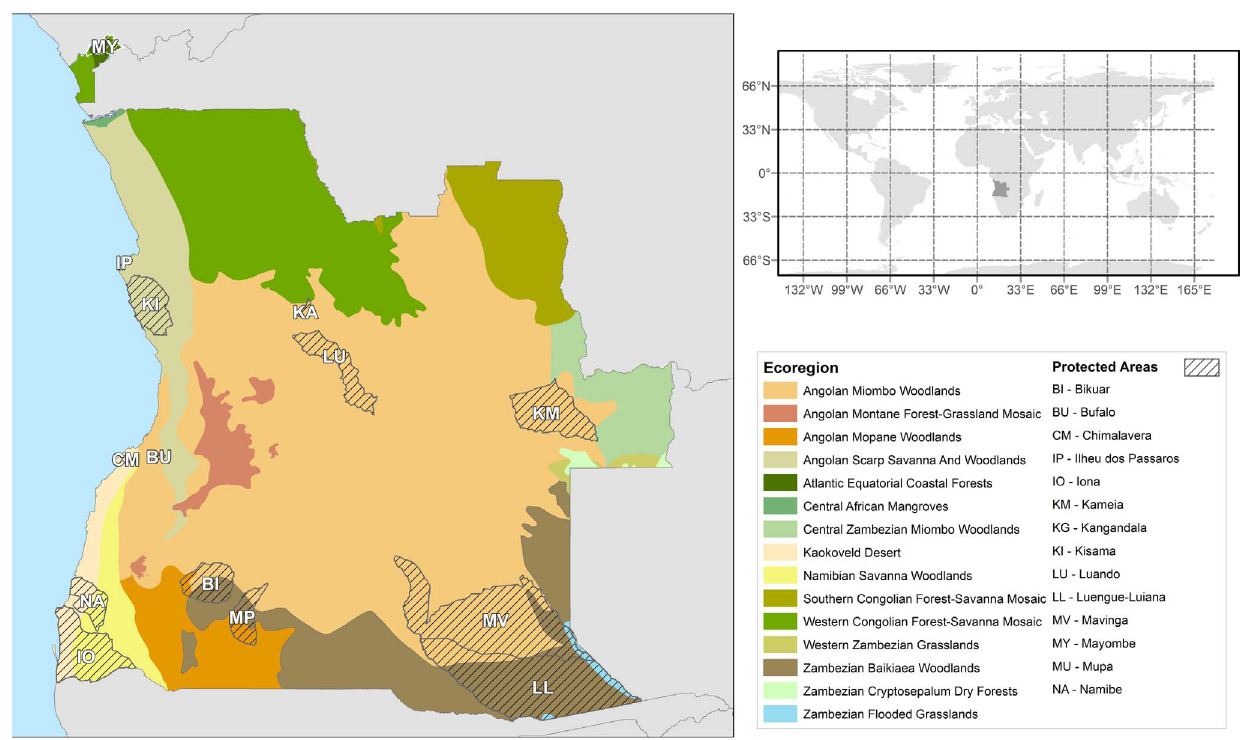
Figure 1. Map of Angola. The 15 WWF ecoregions represented in Angola are displayed together with the network of protected areas (see text for details).